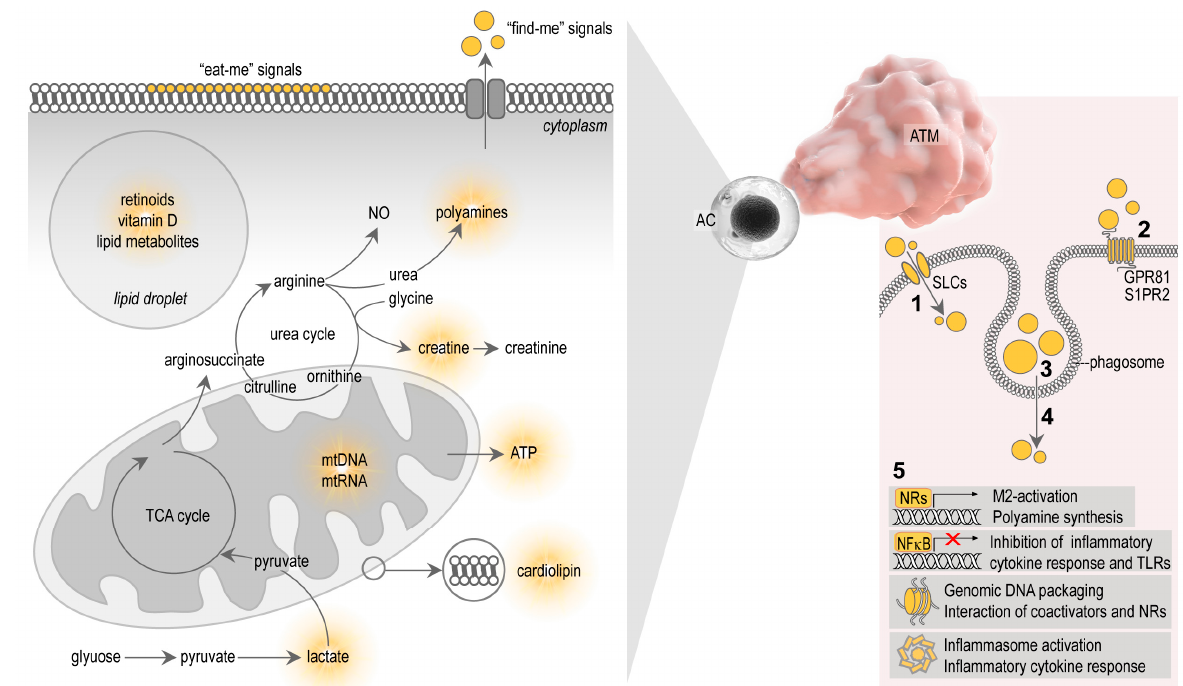
Figure 2. Apoptotic cell metabolites and their potential effects on macrophages. Apoptotic cells express cell surface markers which serve as “eat-me” signals, i.e., they initiate the binding and phagocytosis of the apoptotic cells by macrophages. Dying cells also actively release metabolites that attract macrophages, serving as “find-me” signals. Dying cells have various metabolites that potentially affect macrophage functions—for instance, lipid-soluble vitamins and lipid metabolites of lipid droplets and cell membranes, cytosolic metabolites such as polyamines, creatine, creatinine, ATP and lactate. Mitochondrial membranes and nucleic acids are also potent immune activators. (1) These metabolites may be taken-up by macrophages through solute carriers (SLCs). (2) Apoptotic cell metabolites can also activate G protein-linked membrane receptors in macrophages. (3) Apoptotic remnants are also phagocytosed by the macrophages and digested in phagosomes. (4) Efflux of metabolites from phagosomes may activate macrophage signaling pathways. (5) The macrophage response to apoptotic cells can be M2-activation and polyamine synthesis, and inhibition of NF κ B and cytokine responses. Polyamines affect DNA packaging and the function of NRs. Some apoptotic contents can trigger inflammasome activation, inflammation and pyroptosis. TCA—tricarboxylic acid cycle, NO—nitric oxide, AC—apoptotic cell, ATM—adipose tissue macrophage, GPR 81—G protein-linked receptor 81, S1PR2—sphingosine 1-phosphate receptor 2, NR—nuclear